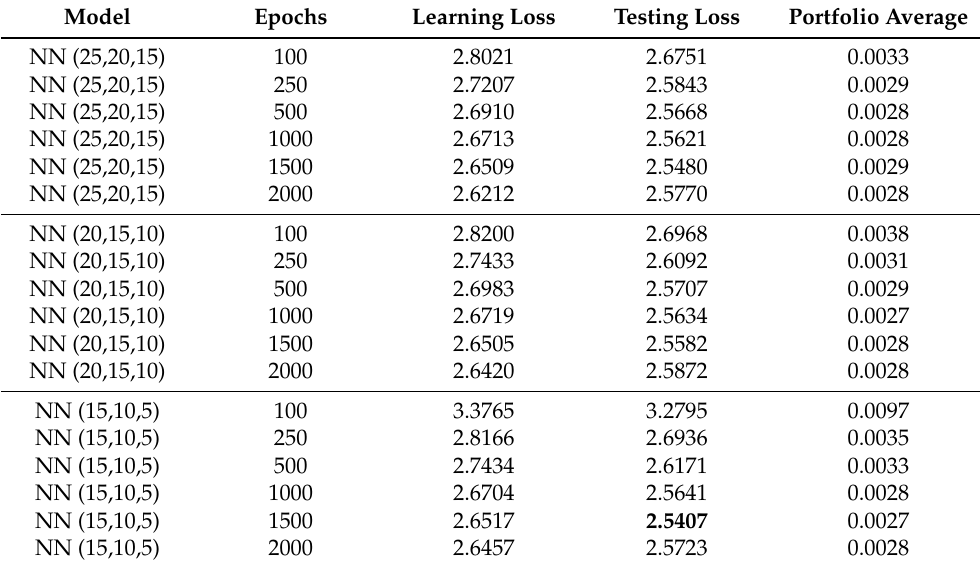
Table 4. The testing loss, learning loss, and portfolio average of the Poisson neural network models with (25,20,15), (20,15,10), and (15,10,5) architectures for different choices of epochs. Model Epochs Learning Loss Testing Loss Portfolio Average NN (25,20,15) 100 2.8021 2.6751 0.0033 NN (25,20,15) 250 2.7207 2.5843 NN (25,20,15)